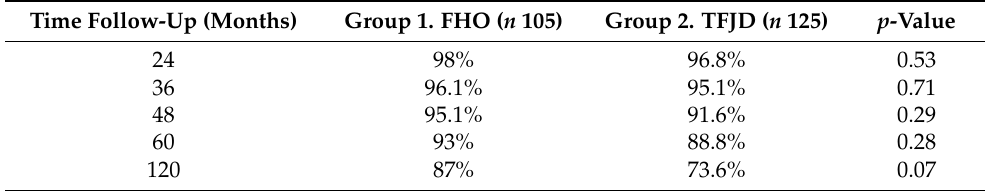
Table 4. Differences in survival percentages at different time points.